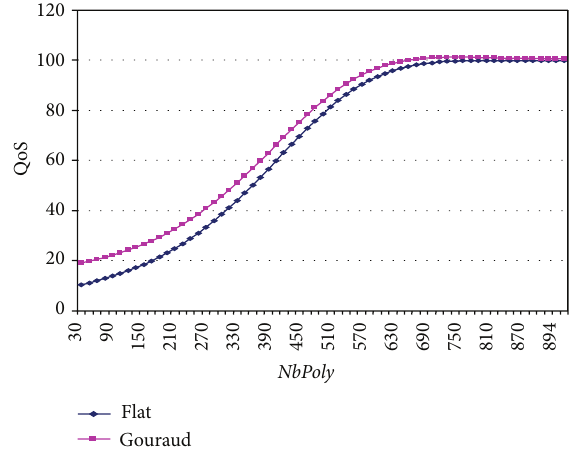
Figure 11: QoS model for the 3D image synthesis.